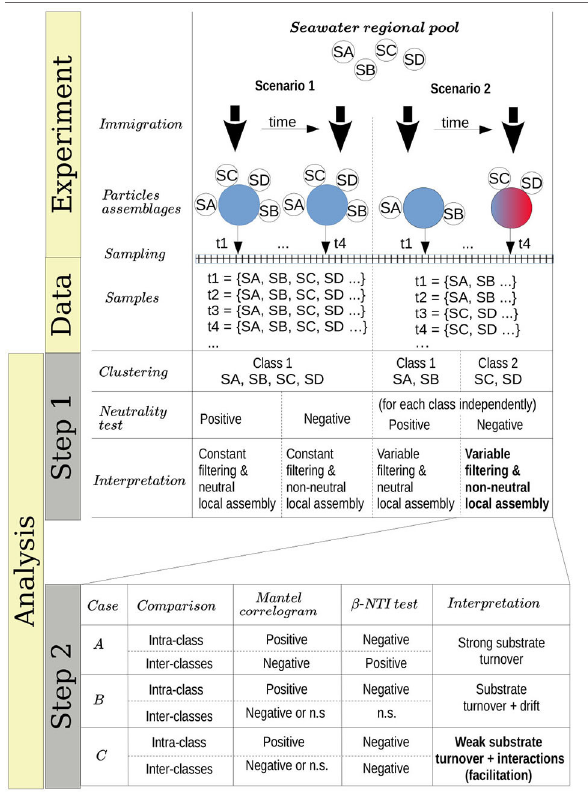
TABLE 1 | Methods and